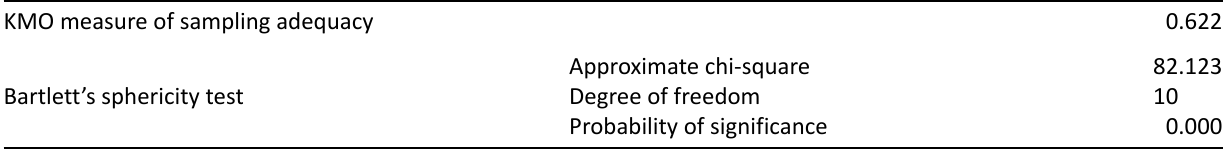
Table 3. Results of KMO and Bartlett’s test for the characteristic variables of the primary rural industry. KMO measure of sampling adequacy